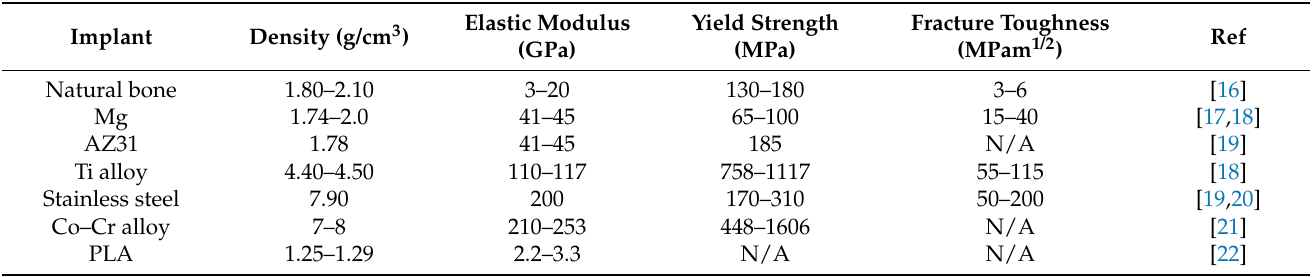
Table 1. Physical and mechanical properties of the main metals used for implants in comparison to natural bone.